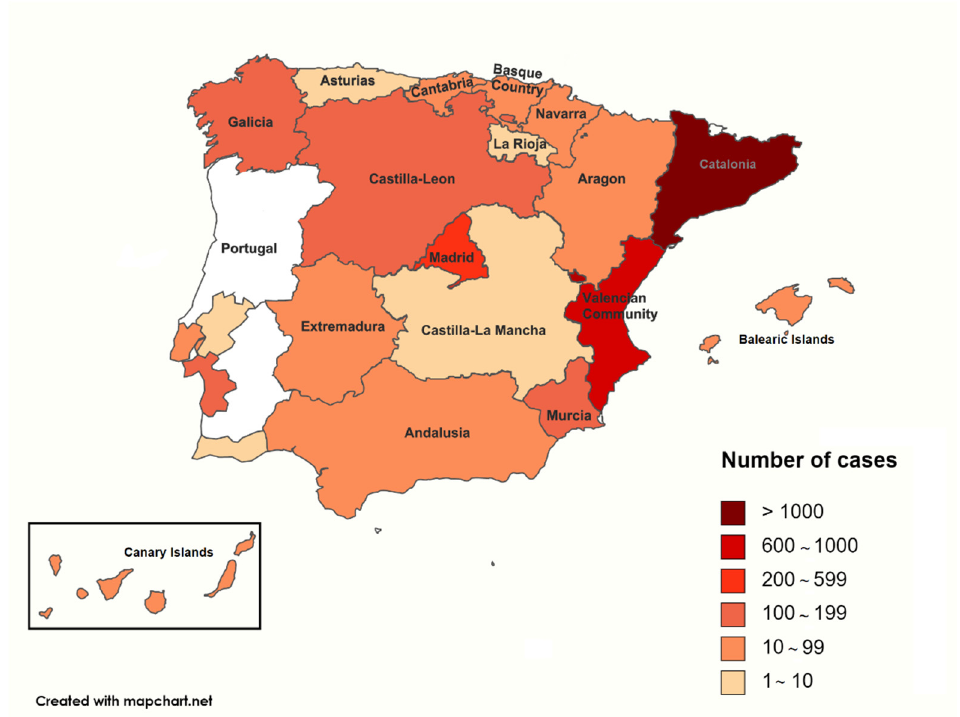
Figure 1. Distribution of clinical samples by geographical origin in Spain and Portugal analyzed between 2016 and 2020.